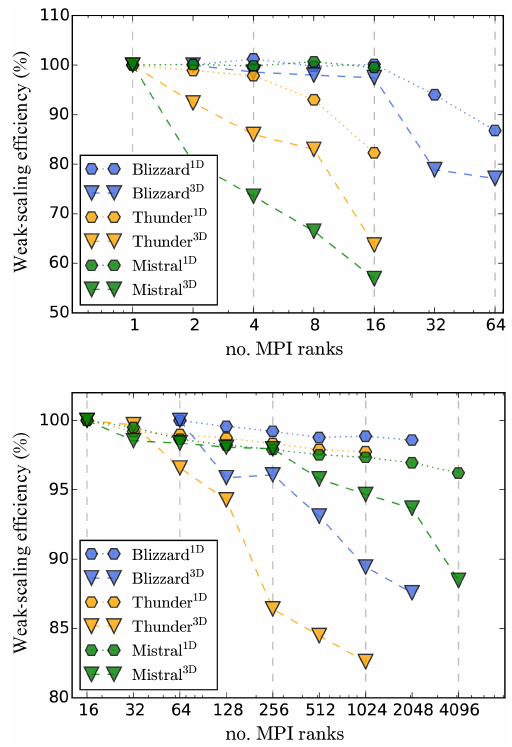
Figure 4. Weak-scaling efficiency running UCLA-LES with inter- active radiation schemes. Experiments measure the time for the ra- diation solvers only (i.e., no dynamics or computation of optical properties). Timings are given as a best of 10 runs. Weak-scaling efficiency is given for the TenStream solver (triangle markers) as well as for a two-stream solver (hexagonal markers). Scaling behav- ior compared to single core computations (remaining on one com- pute node)(left). Compute node parallel scaling (normalized against a single node)(right). The individually colored lines correspond to different machines (see Table 1 for details) and calculations once done with the delta-Eddington two-stream solver (hexagons) and once with the TenStream solver